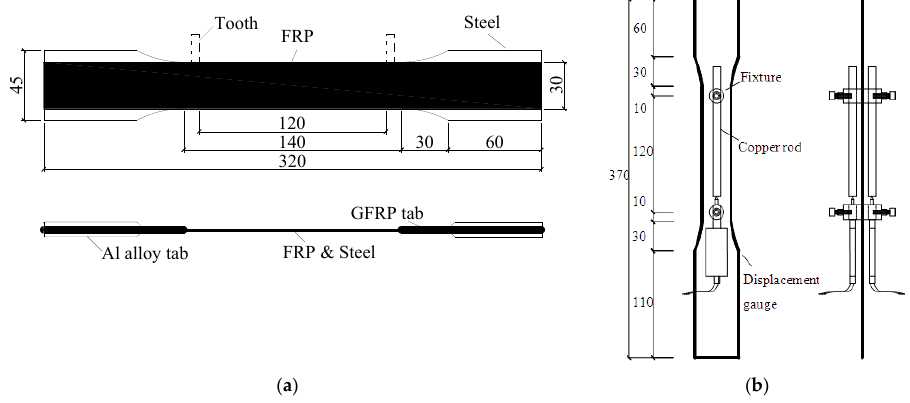
Figure 1. Geometry of specimens: ( a ) specimens for ambient temperature; and ( b ) specimens for elevated temperatures (unit: mm).